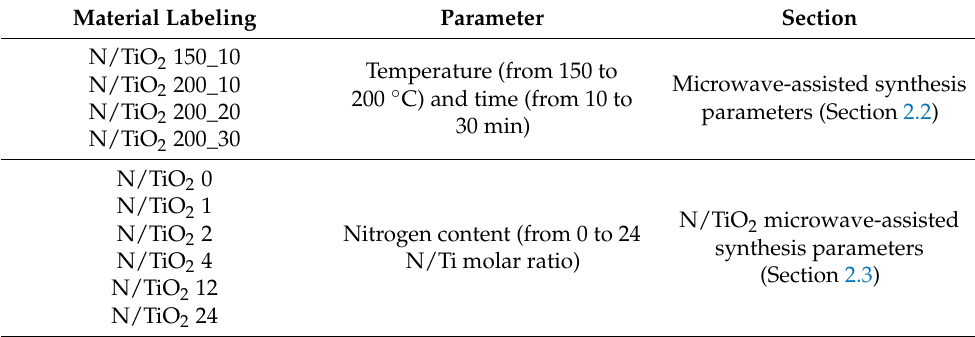
Table 1. Material labeling and evaluated parameters. Material Labeling